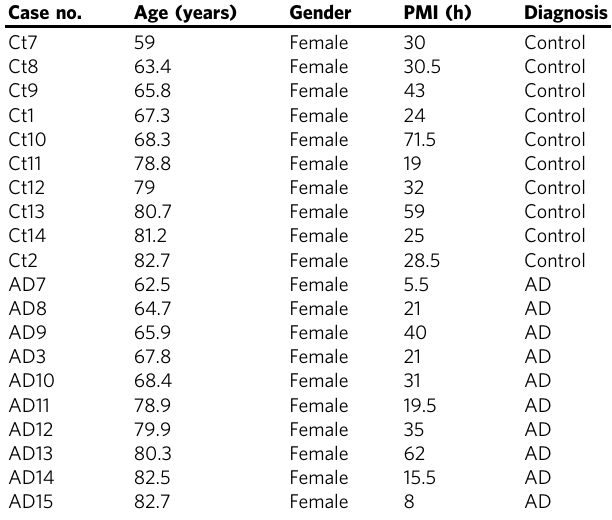
Table 1 The age, gender, post mortem interval (PMI) and diagnosis for the controls and cases used for immuno fl uorescence